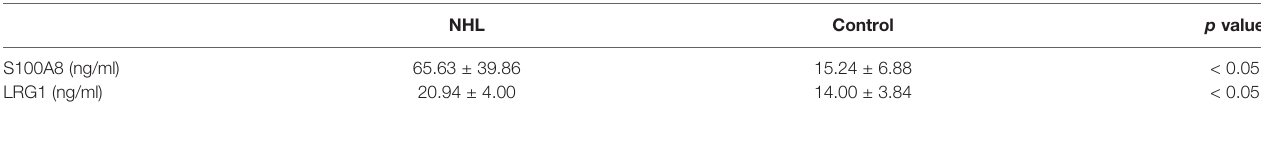
TABLE 3 | Serum concentrations of S100A8 and LRG1 in pediatric NHL patients and healthy